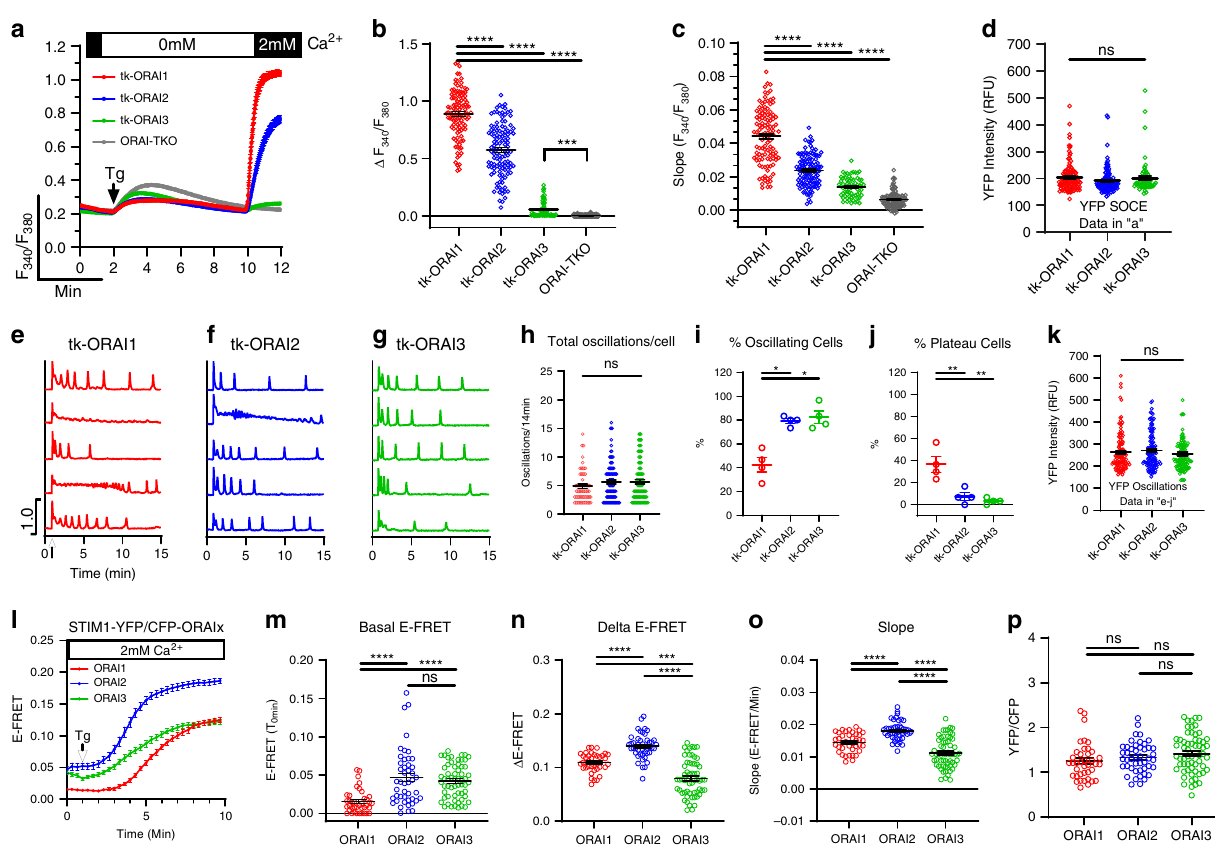
Fig. 3 ORAI3 and ORAI2 interact with STIM1 under basal conditions. a Measurements of ER Ca 2 + release (in 0 mM Ca 2 + ) and SOCE (in 2 mM Ca 2 + ) upon store depletion with 2 µ M thapsigargin (Tg) in ORAI-TKO cells (untransfected controls) and in ORAI-TKO cells individually rescued with either ORAI1, ORAI2, or ORAI3 driven by the “ weak ” thymidine kinase (tk) promoter; all traces are plotted as mean ± SEM. b – d Scatter blot representing quanti fi cation of the magnitude ( b ) and slope ( c ) of SOCE and fl uorescence intensity ( d ) of transfected tk-driven YFP-ORAI isoforms in a (for b – d from left to right n = 112, 116, 67, and 120; n -values correspond to individual cells). e – g Representative Ca 2 + oscillations in response to 10 µ M carbachol (Cch; added where indicated by arrow) measured using Fura2 over the course of 15 min in ORAI-TKO cells transfected with individual tk-driven ORAI isoforms. Cells were maintained in HBSS containing 2 mM Ca 2 + for the duration of the experiments and stimulated with 10 µ M Cch at 1 min (as indicated by arrow in “ e ” ). Representative traces from fi ve cells/condition were chosen to represent the datasets as a whole. h – j Quanti fi cation of total oscillations/14 min ( h ), % of oscillating cells ( n = 51(ORAI1), 94(ORAI2), and 100(ORAI3); data represent individual cells) ( i ), and % of plateau cells ( j ) for data in e – g (for i , j , n = 4 for all conditions; data represent independent experiments). k Fluorescence intensity of transfected tk-driven YFP-ORAI isoforms for data in e – j ) ( n = 120 (ORAI1), 119 (ORAI2), and 118 (ORAI3); data represent individual cells). l E-FRET represented as mean ± SEM between STIM1-YFP and either CFP-ORAI isoform at rest and after addition of 2 µ M thapsigargin (Tg) in HBSS containing 2 mM Ca 2 + . m – p Scatter blots representing quanti fi cation of basal E-FRET ( m ), the magnitude ( n ), and slope ( o ) of E-FRET change after addition of thapsigargin and YFP/CFP fl uorescence ratios ( p ) from data in l (for m – p , n = 39 (ORAI1), 46 (ORAI2), and 60 (ORAI3); data represent individual cells). All data are represented as mean ± SEM. Panels b – d , h , k , m – p were statistically analyzed using the Kruskal – Wallis one-way ANOVA with multiple comparisons. Panels i , j were analyzed using one-way ANOVA with multiple comparisons (* p < 0.05; ** p < 0.01; *** p < 0.001; **** p < 0.0001; ns, not signi fi cant). All comparisons were made to